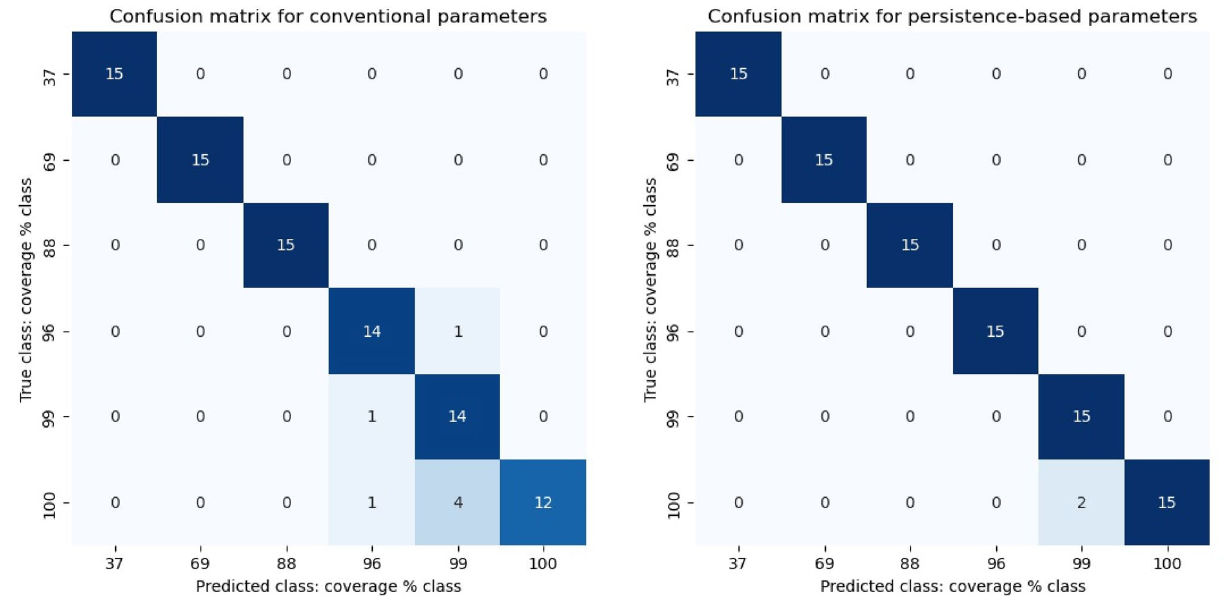
Figure 7. Confusion matrices for conventional and persistence-based